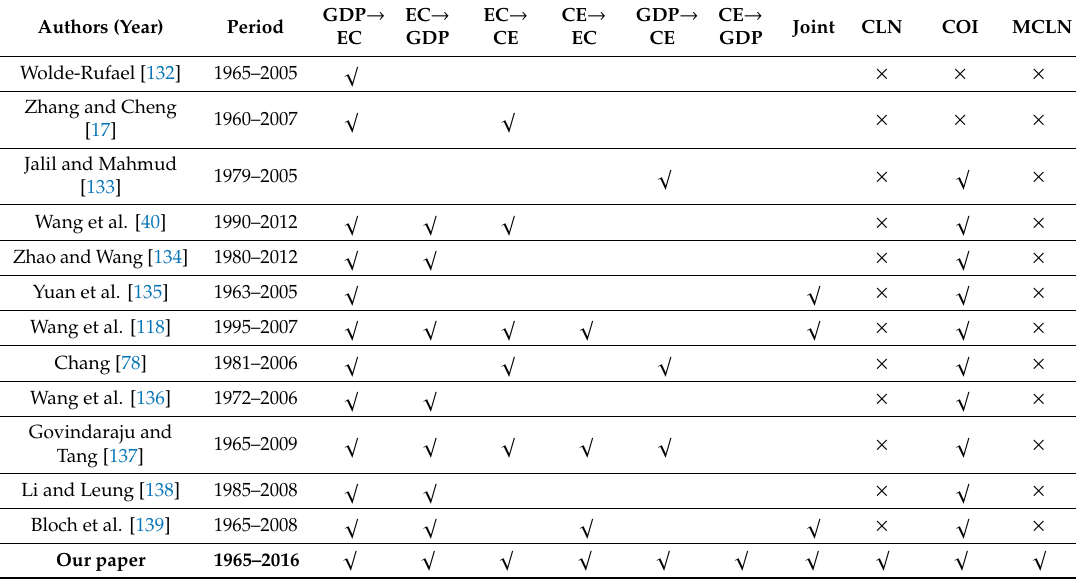
Table A1. Comparison of the conclusions drawn in this paper and those in the literature. Authors (Year)